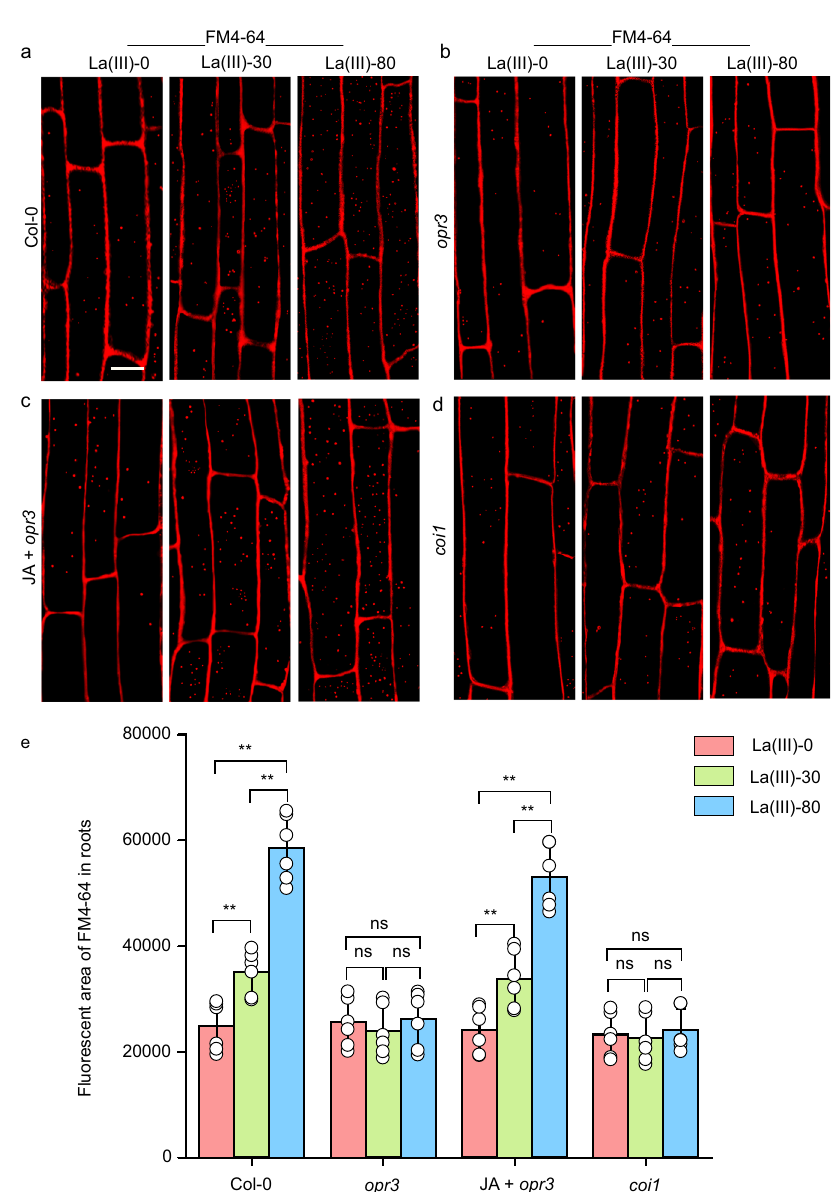
Fig. 4 The production of JA changed endocytosis. a – d Visualization of endocytosis labeled with FM4-64 in Col-0 ( a ), opr3 ( b ), JA-treated opr3 ( c ), and coi1 ( d ) roots 12 h after treatment of leaves with 0, 30, or 80 μ M La(III). Bars = 10 μ m. Representative images from six independent measurements and three biological replicates (each replicate represents an independently treated plant) per measurement are represented. e Quantitative analysis of the fl uorescent area of FM4-64 in root cells of Col-0, opr3 , JA-treated opr3 , and coi1 (data come from a – d ). Values shown are means ± SEM. One-way ANOVA analysis with LSD multiple comparisons test ( n = 6, ** p < 0.01, n.s.: no signi fi